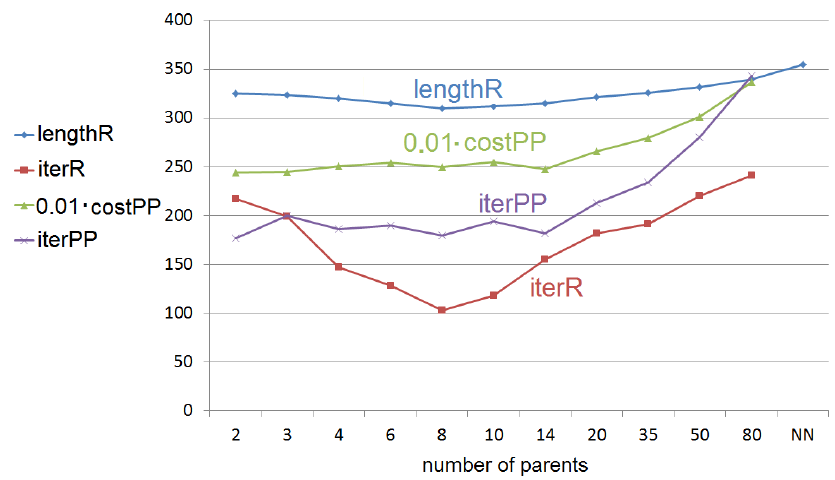
Figure 8. The obtained route length lengthR (the lower the better) and product placement cost costPP (the lower the better) and the number of iterations for route optimization iterR with MP-HGreX and for product placement optimization iterP with MP-AEX (graphical representation of the data from Tables 2 and